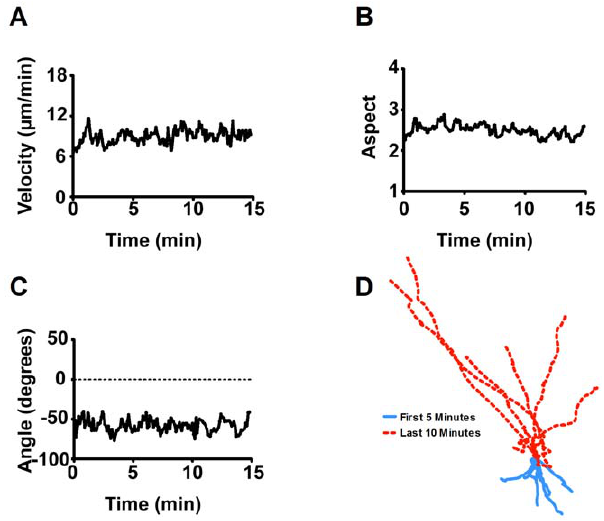
Figure 3. Analysis of Dictyostelium cell behaviour over a 15 min period under control conditions. Mean data representing 85 cell chemotaxis over a 15 min period for A: cell velocity; B: cell aspect; C: cell angular movement; D: cell tracking (where the co-ordinates of individual cells were illustrated following normalisation to (0,0) at 5 min, represented by single lines for 0–5 min (blue) or 5–15 min (dashed red) and cell direction has been adjusted so that cells are moving up the page). Data from A–C is presented as mean of triplicate experiments analysing approximately 30 cells in each.